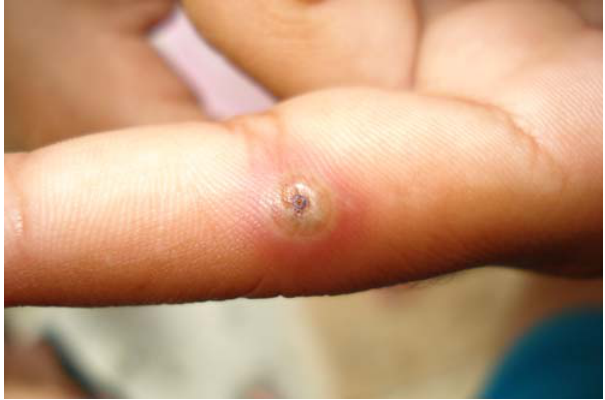
Figure 2. A single tungiasis lesion on the finger of a 7-year-old boy from Brazil, with surrounding erythema.